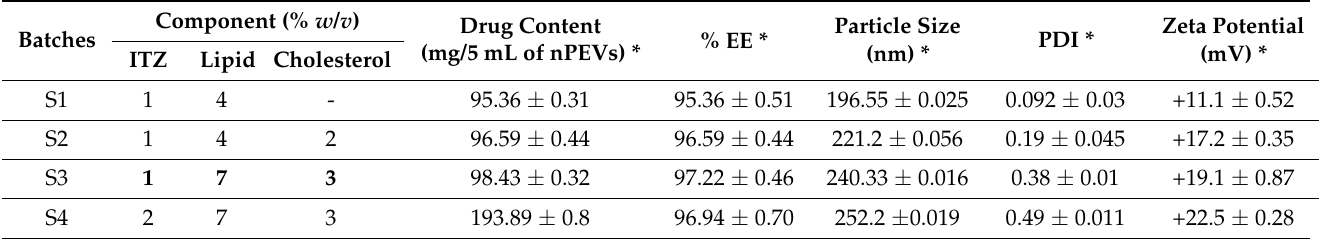
Table 1. Composition and characterization of ITZ-nPEVs